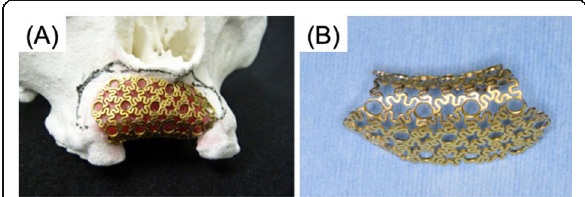
Fig. 3 3D custom-made titanium mesh plate. a 3D custom plate